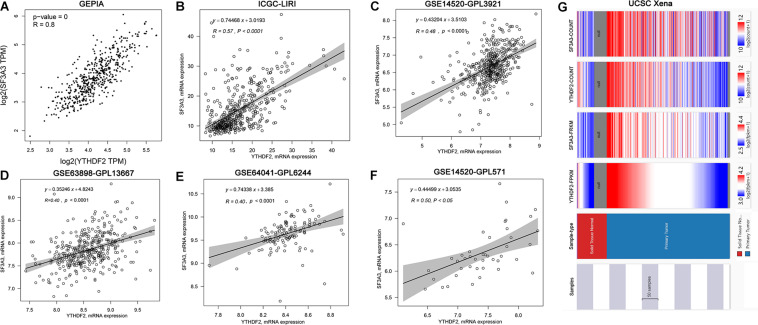
Correlation analyses of YTH domain family (YTHDF) 2 expression and SF3A3 expression in publicly available datasets. (A) Gene Expression Profiling Interactive Analysis (GEPIA). (B) International Cancer Genome Consortium (ICGC)-LIRI. (C) GSE14520-GPL3921. (D) GSE63898-GPL13667. (E) GSE64041-GPL6244. (F) GSE14520-GPL571. (G) UCSC Xena.